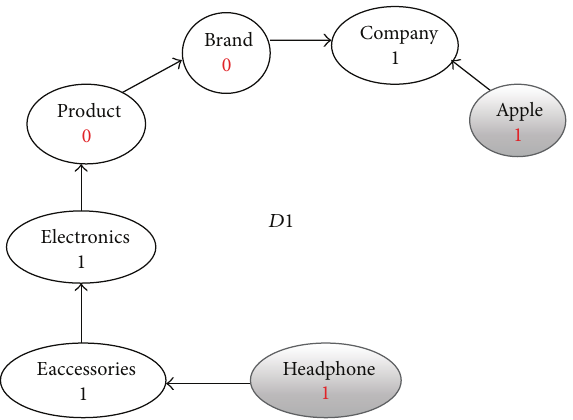
Figure 15: Frequencies after spreading activation for 𝐷1 .